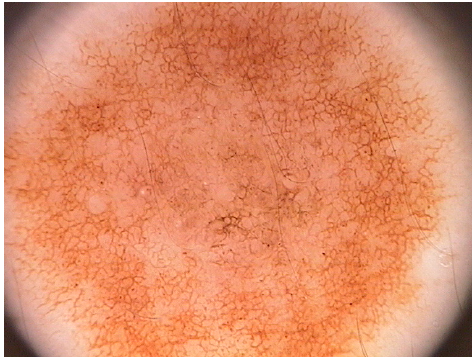
Figure 2. A typical dermoscopy image of a skin nevus.